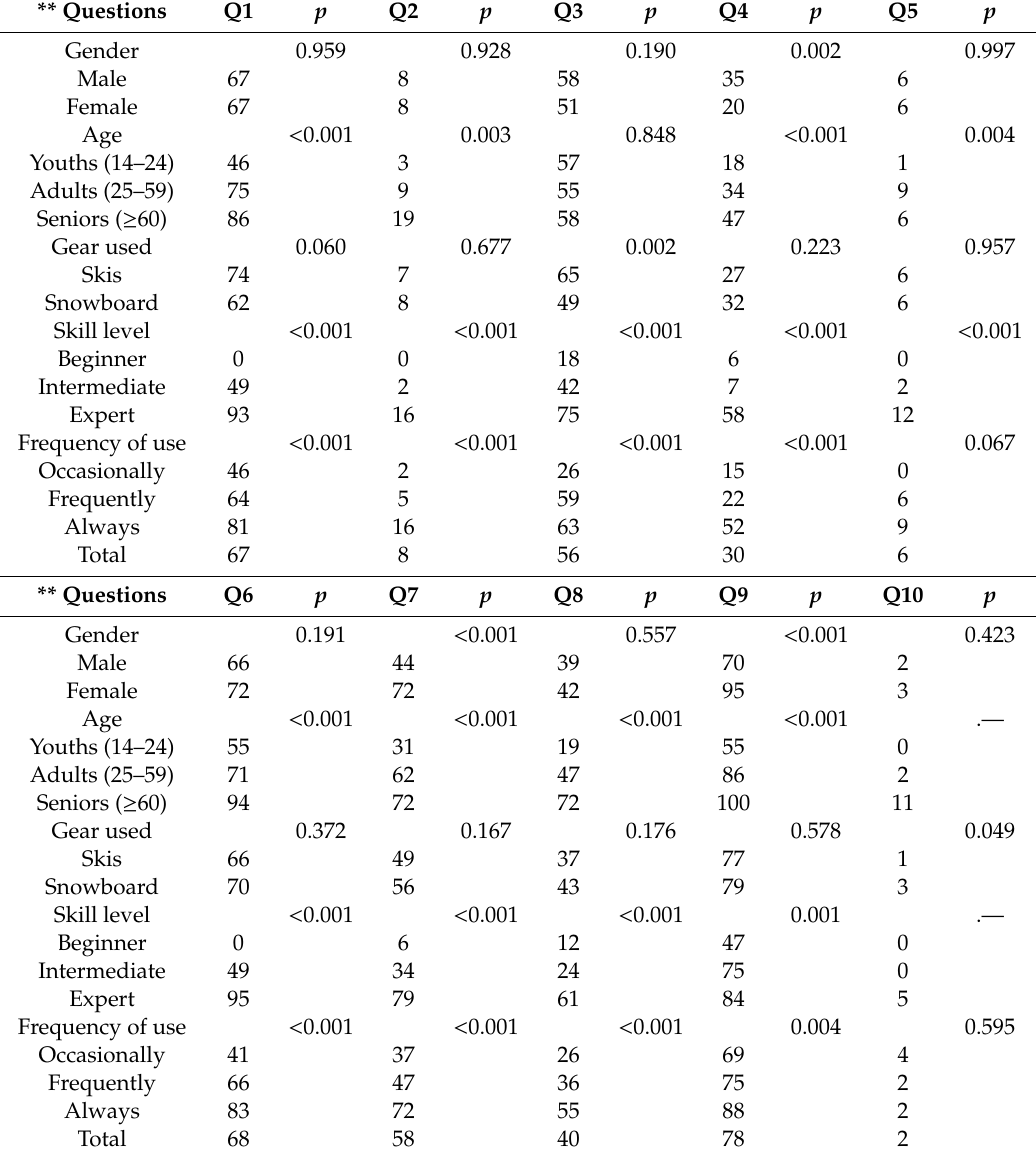
Table 8. Actual passive knowledge of existing rules for SPs among survey participants